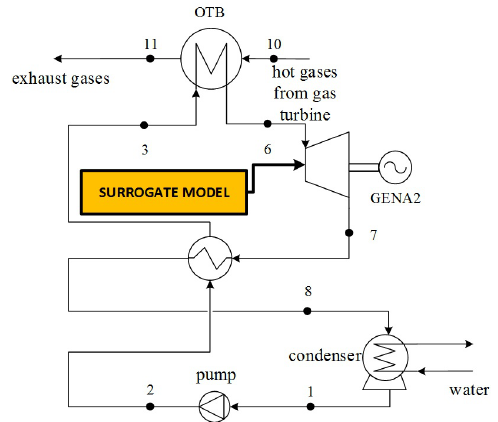
Figure 3. Organic Rankine cycle (ORC) plant layout showing the coupling with turbine surrogate models.